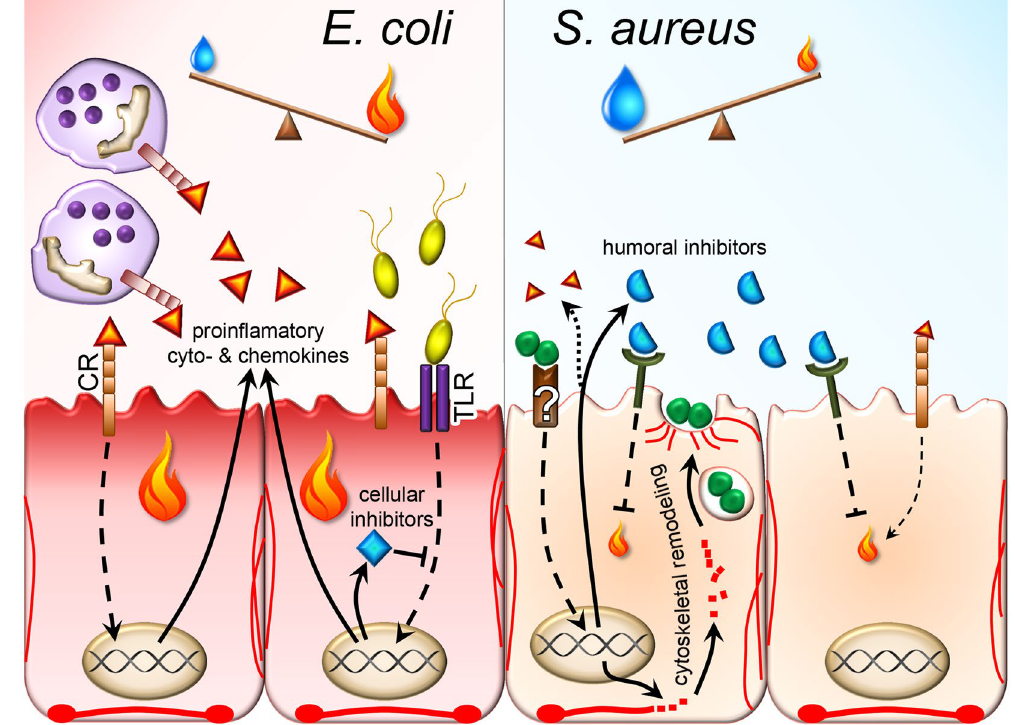
Figure 5. Graphical summary of the key differences between the early events after E . coli vs S . aureus udder infection. E . coli (yellow) activates in the epithelial cells TLR signaling triggering synthesis and secretion of proinflammatory factors (cyto- and chemokines, triangles), recruiting and activating cellular factors of innate immunity through activating cytokine receptor (CR) signaling. Also immune dampening factors are activated (blue diamond) but, on balance inflammation (flame) outweighs immune dampening (blue water drop). Knobbed red lines symbolize the ventral fibers terminated by focal adhesion plaques. No alteration of the actin cytoskeleton occurs. S . aureus (green Staphylococci) presence is perceived by the epithelial cell through unknown receptors rather than through TLRs or other classical PRRs. This triggers synthesis and secretion of immune dampening factors (blue crescents) surmounting in their effect any proinflammatory stimulation. Moreover, S . aureus is internalized into the epithelial cells, facilitated through rearrangement and interaction with the actin cytoskeleton. This enables pathogen persistence eventually resulting in chronic